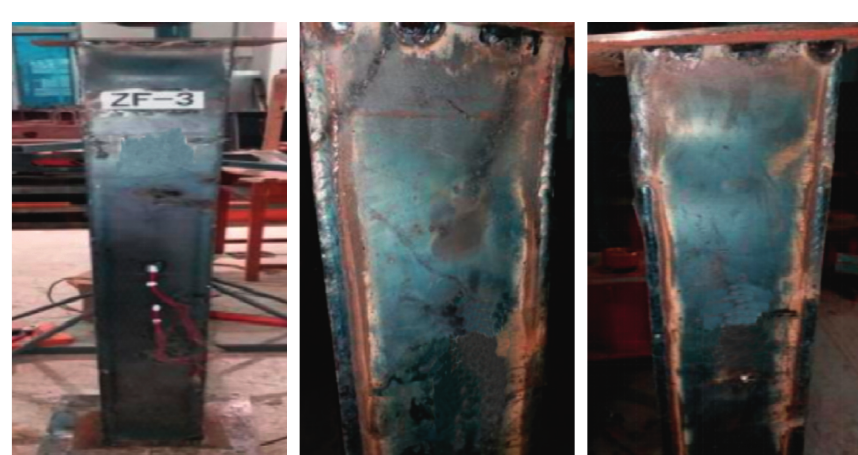
Figure 25: ZF-3 failure